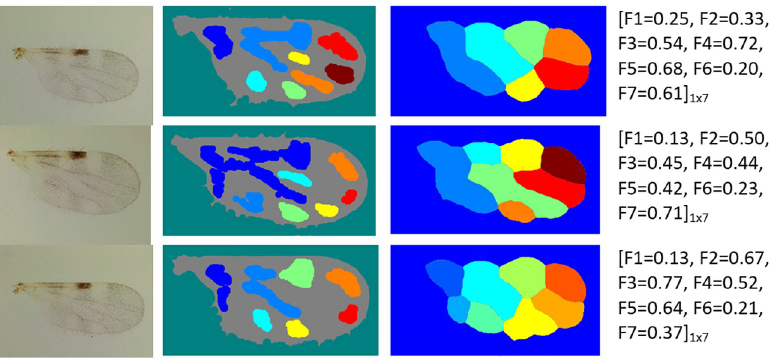
Fig 4. Performance of the proposed method on C. pusillus species samples. From left to right column: original wing image, particle detection, segmentation of zones of interest through the watershed method, and the final feature vector output obtained.